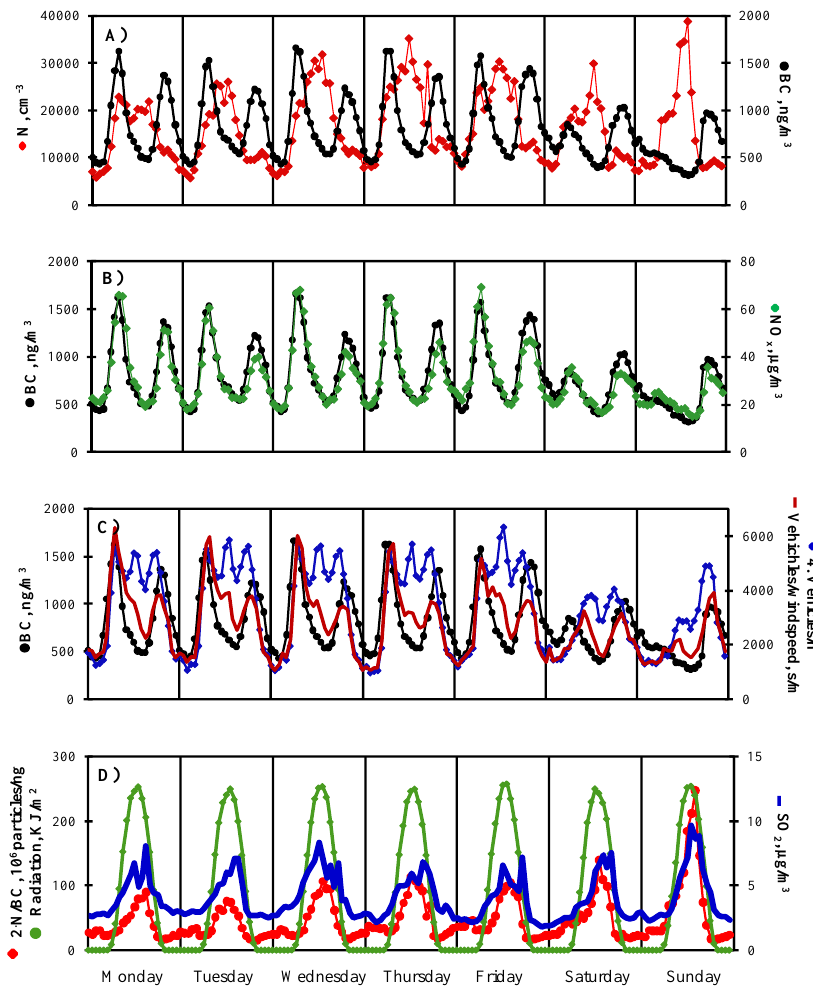
Fig. 4. Hourly average values of particles (N and BC) and gaseous pollutant (NO x and SO 2 ) concentrations, and of road-traffic intensity (number of vehicles/hour), the road-traffic intensity/wind speed ratio, of the N/BC ratio and solar radiation, for every day of the